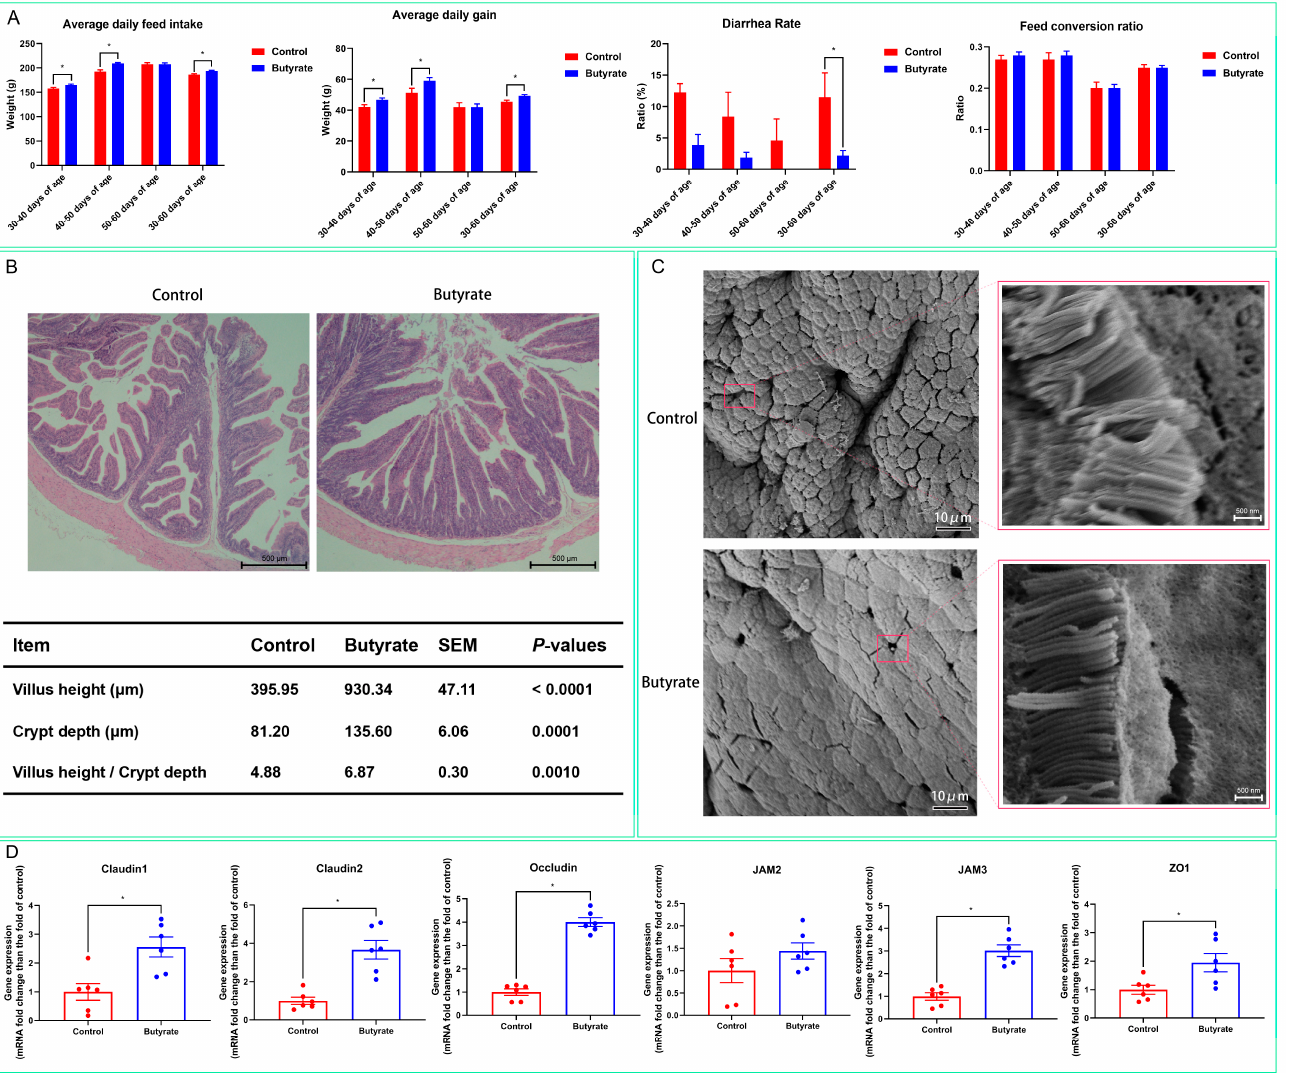
Figure 1. Effect of dietary butyrate on growth status and intestinal epithelial barrier in weanling rabbits. ( A ) Growth of weanling rabbits from 30 days of age to 60 days of age ( n = 60). ( B ) Observation of ileum villus height and crypt depth in weanling rabbits at 50 days of age ( n = 6). ( C ) Observation of the microstructure of the ileum mucosal epithelium in weanling rabbits at 50 days of age ( n = 6). ( D ) Expression of genes associated with the intestinal epithelial barrier in the ileal mucosal epithelium of weanling rabbits at 50 days of age ( n = 6). Date are expressed as mean ± SEM, * p < 0.05.